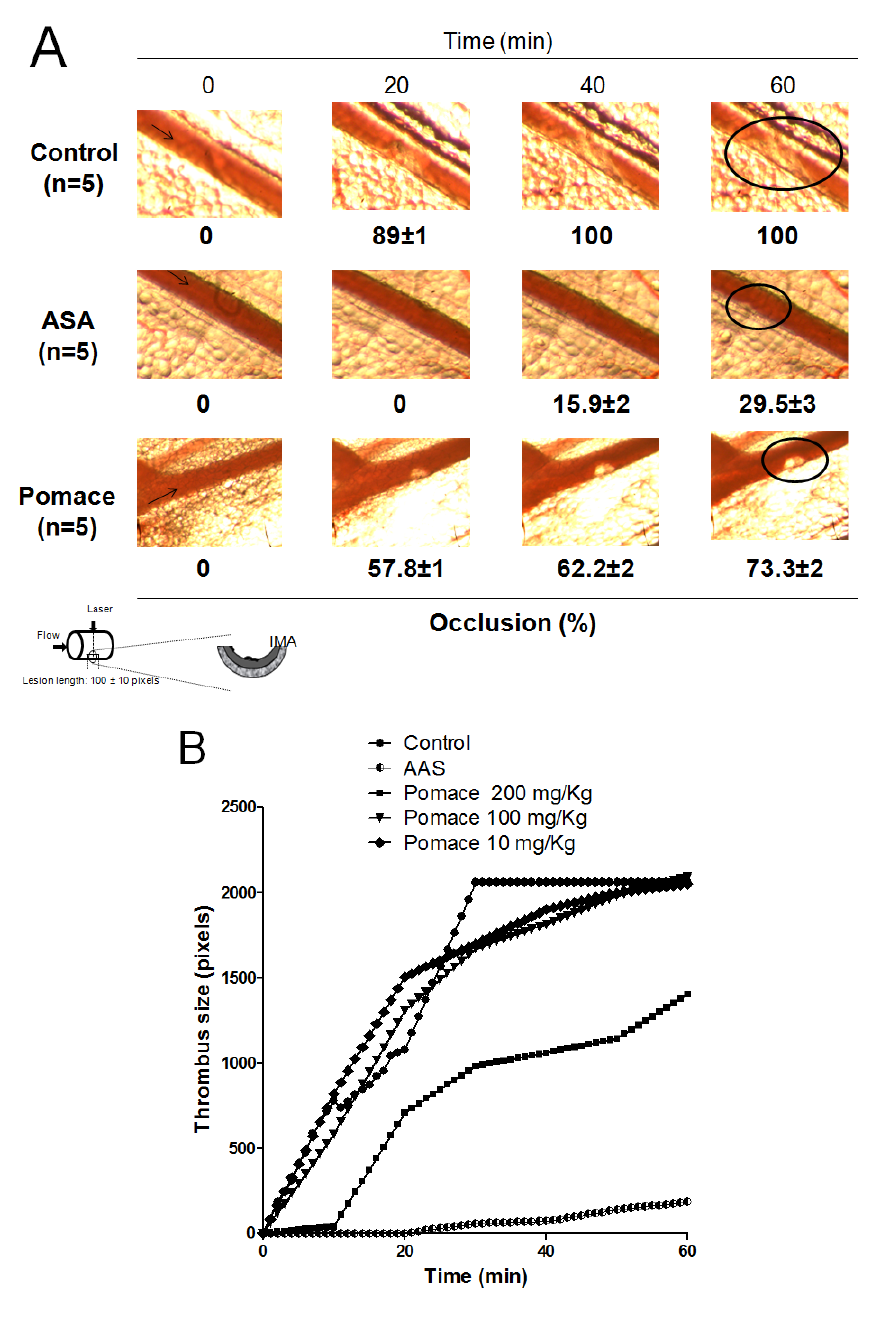
Figure 2. Pomace extract inhibits laser-induced thrombus formation in mesenteric artery of C57BL/6 mice. ( A ) Representative images of thrombus formation at baseline, 20, 40 and 60 min after laser-injured vascular injury in mouse mesenteric artery. ( B ) Representative time course changes of thrombus growth rate among the control (saline), pomace extract and ASA at 60 min after laser